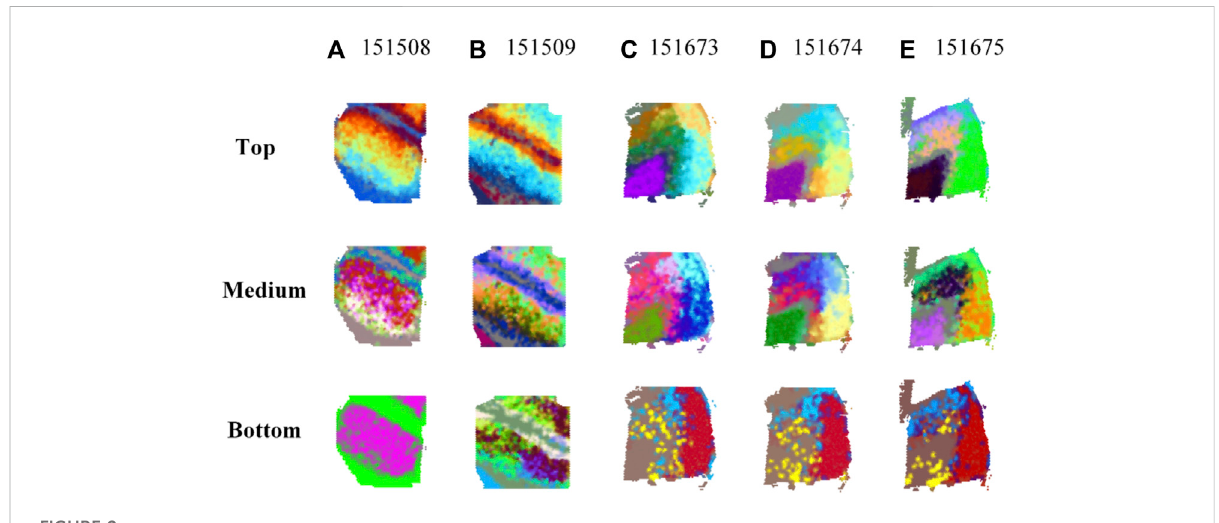
FIGURE 2 Comparison results of top-, medium-, and bottom-ranked RGB images based on transformed embeddings in MP-MIM on (A) 151508, (B) 151509, (C) 151673, (D) 151674, and (E) 151675 samples.